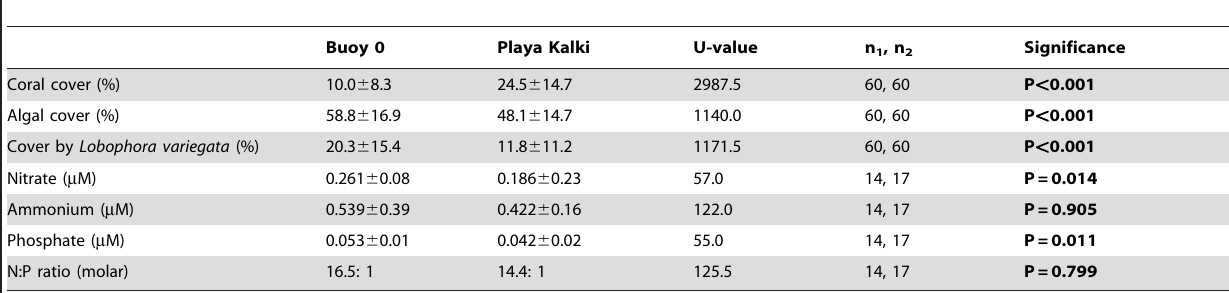
Table 1. Comparison of environmental characteristics at the research sites Buoy 0 and Playa